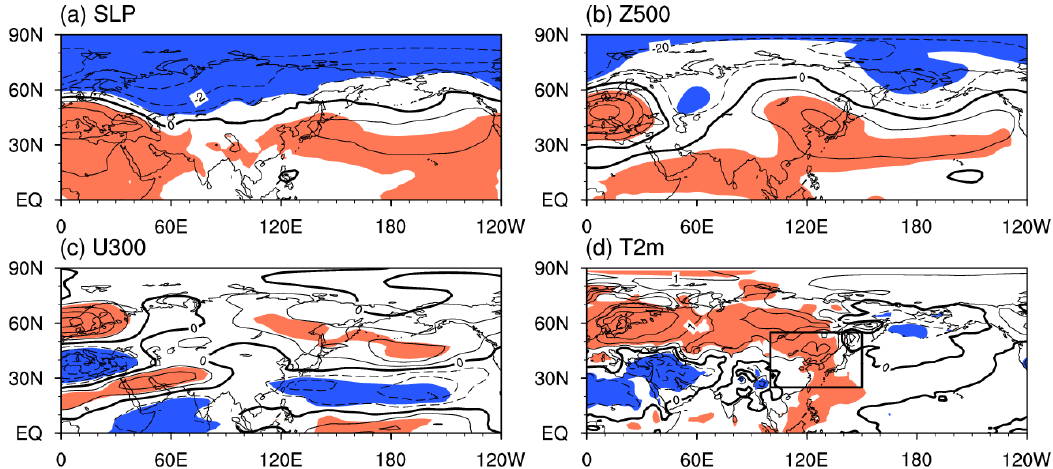
Figure 9. The ( a ) SLP (CI = 1 hPa), ( b ) Z500 (CI = 10 gpm), ( c ) U300 (CI = 1 m·s − 1 ), and ( d ) T2m (CI = 0.5 °C) pattern regressed against the AO index during 1956–1990. The black rectangle-shaped box in ( d ) indicates East Asia (100–150°E, 25–55°N). Shaded values are significant, exceeding 95% confidence level based on Student’s t -test.